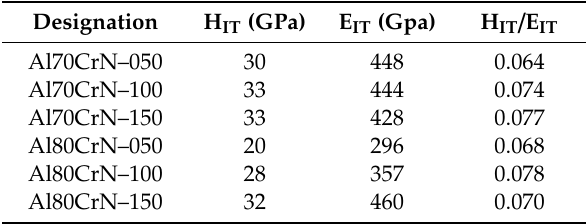
Table 2. Mechanical properties of AlCrN variants.